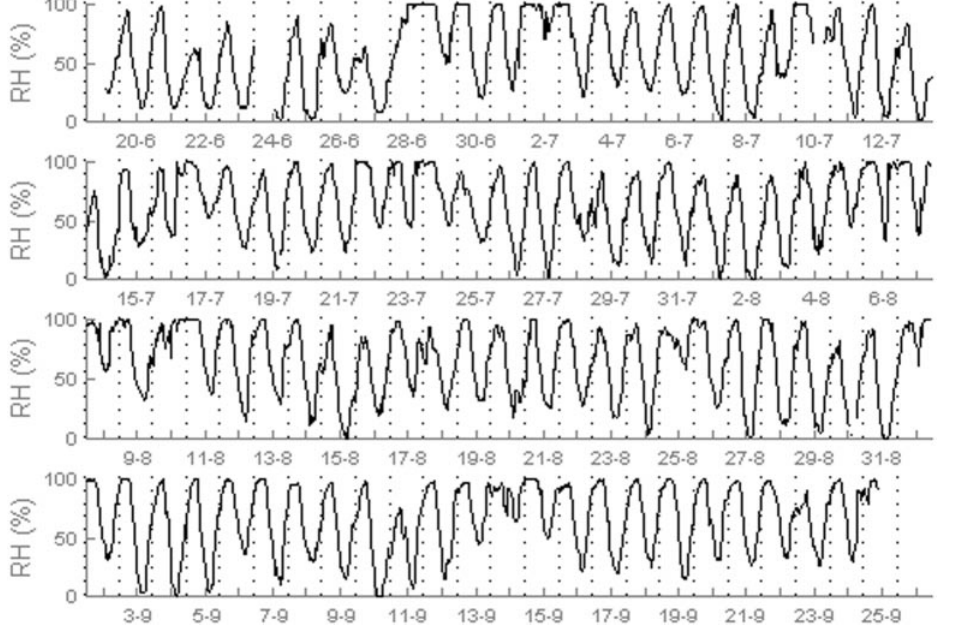
Fig. 5. Time series for the rela- tive humidity for the 1997 WELSONS experiment. Values >95% should not be used be- cause the measurement range of the sensor extends only from 20% to 95%